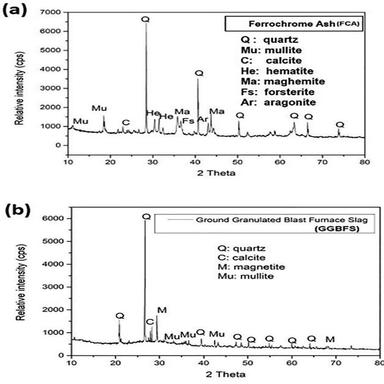
Compressive strength of FCA based geopolymer with GGBFS and lime.